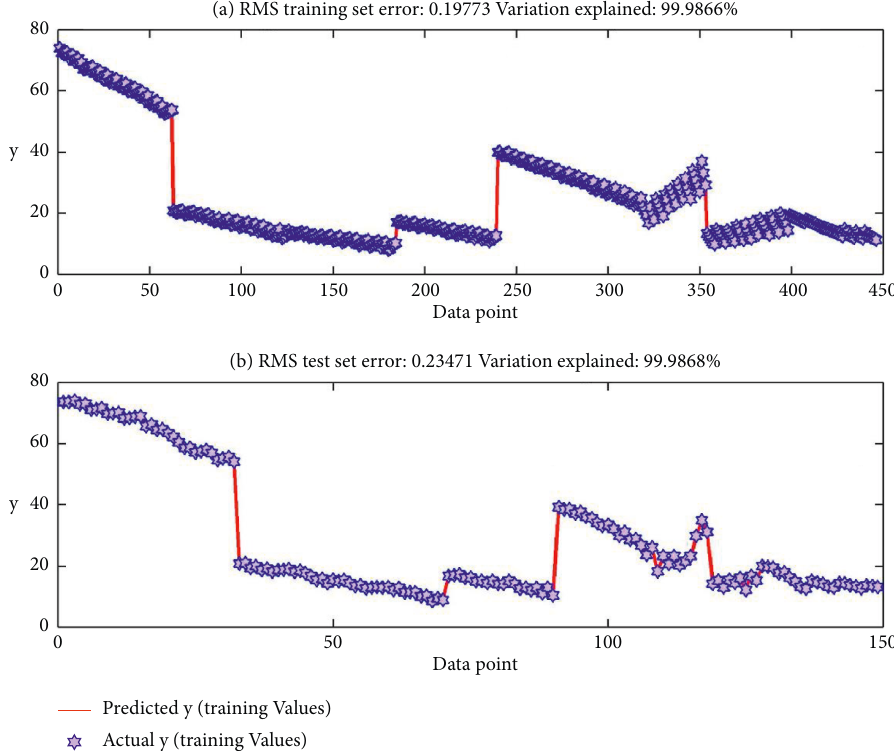
Figure 8: Simultaneous demonstration of GEP output and experimental alkali metals’ density for (a) training and (b) testing.